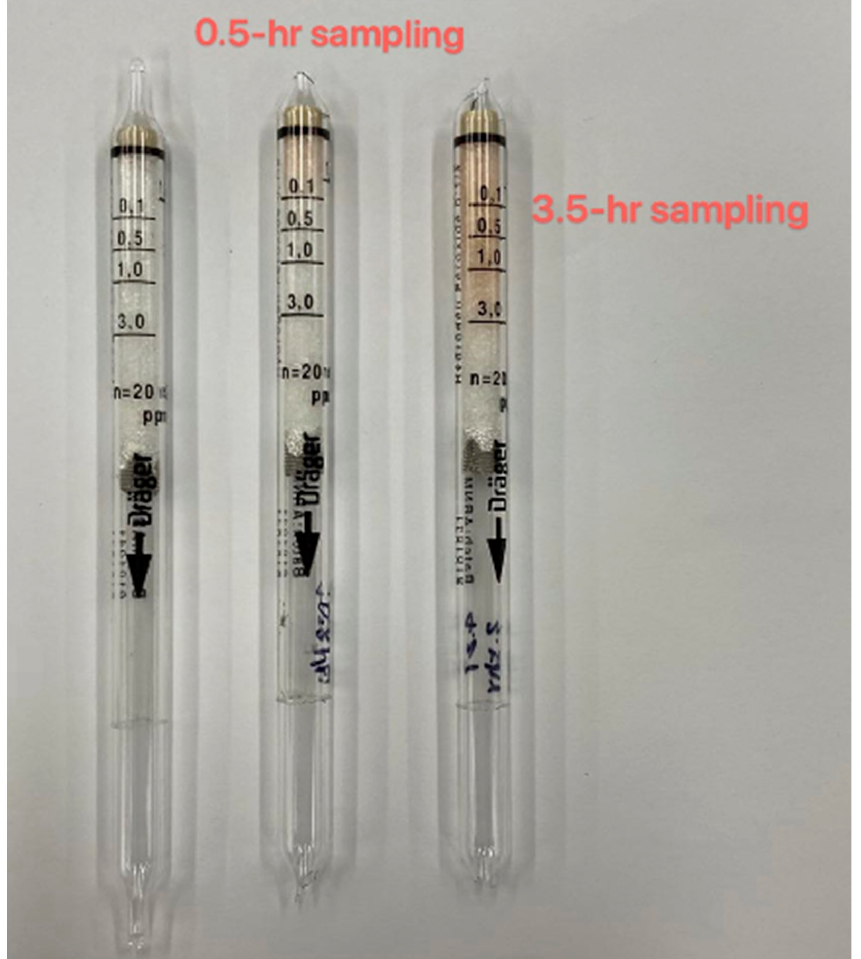
Figure 5. Results from colorimetric sampling with a H 2 O 2 Dräger-Tube installed downstream of the air cleaner: before sampling, after 0.5 h, and after 3.5 h of sampling.